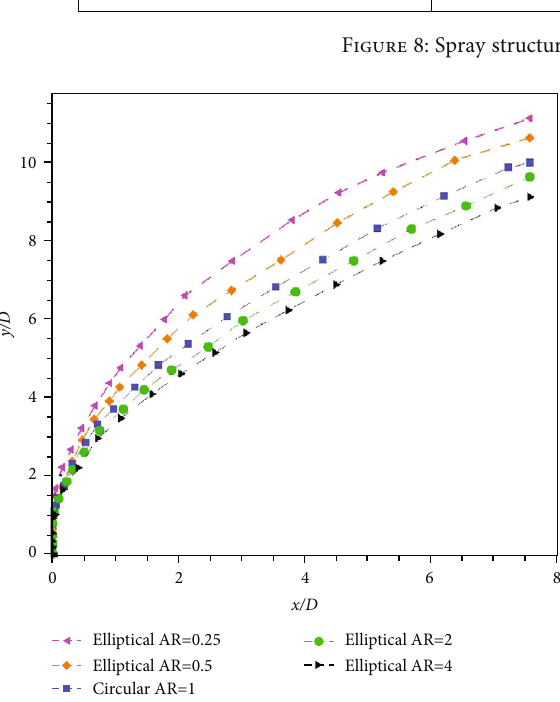
Figure 8: Spray structure of the liquid jet in di ff erent AR.